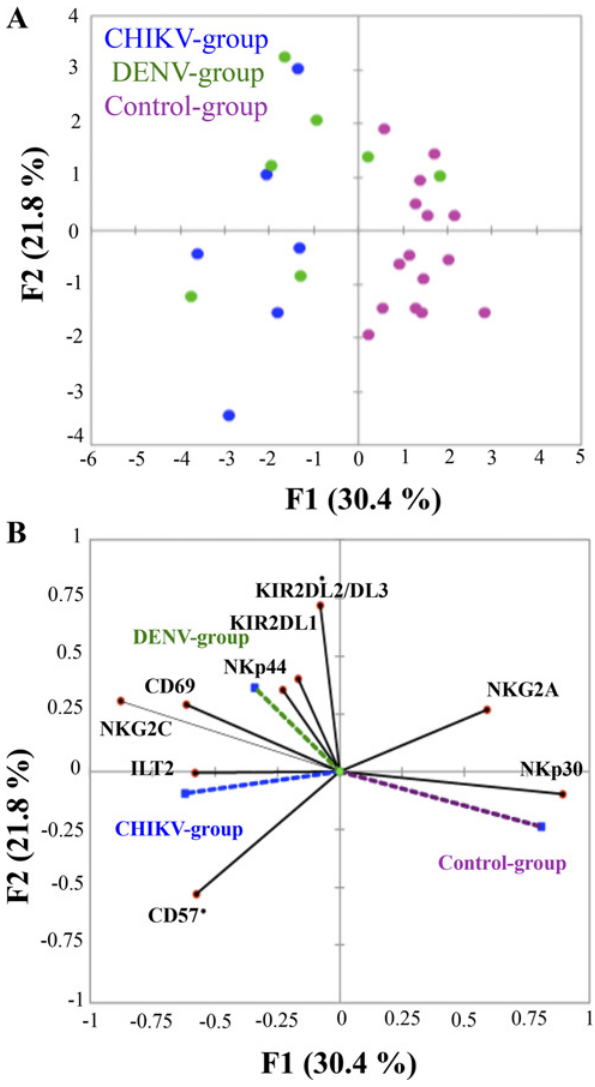
Fig 5. Principal component analysis graphically showing the (A) statistical distribution of the individuals, according to the differential expression of NK-cell markers, and (B) statistical proximity between these different markers. DENV-2 + patients are noted in green, CHIKV + patients in blue, and healthy donors in